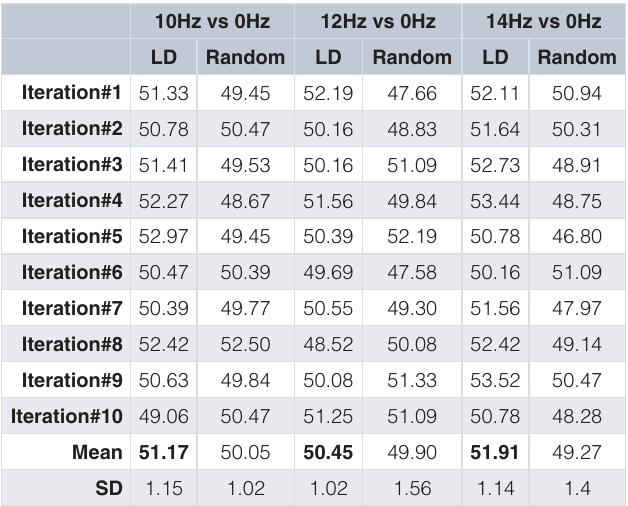
Table 6. Percentages of classification accuracies between the periods of stimulation and non-stimulation for the non-stimulated participants.